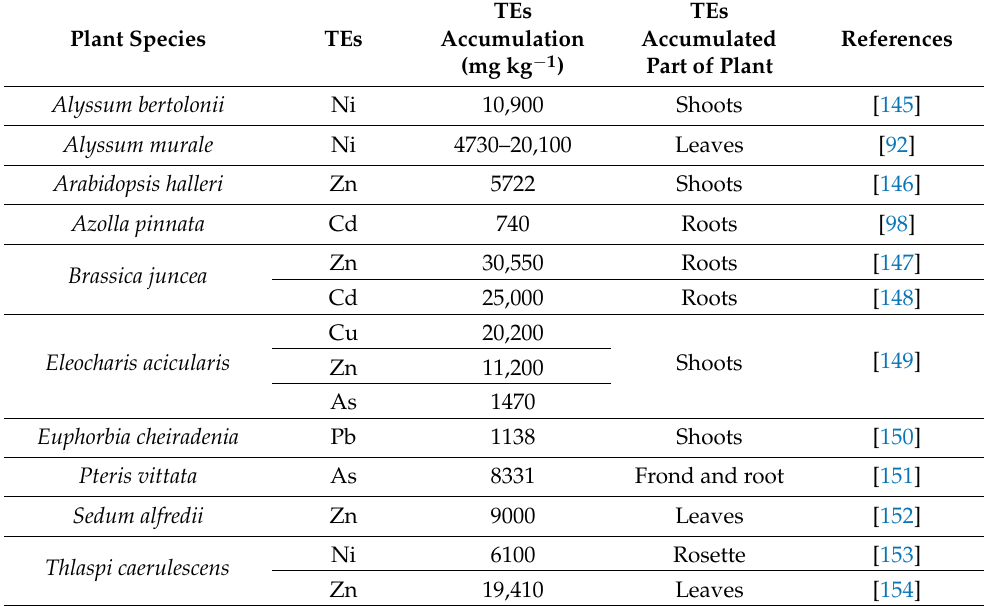
Table 2. Examples of hyperaccumulators and the TEs content in part of plant.